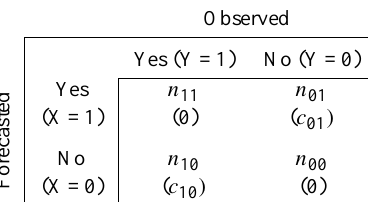
Table 10. 2 × 2 contingency table and associated loss table (denoted by c ij ) , following Mozer and Briggs